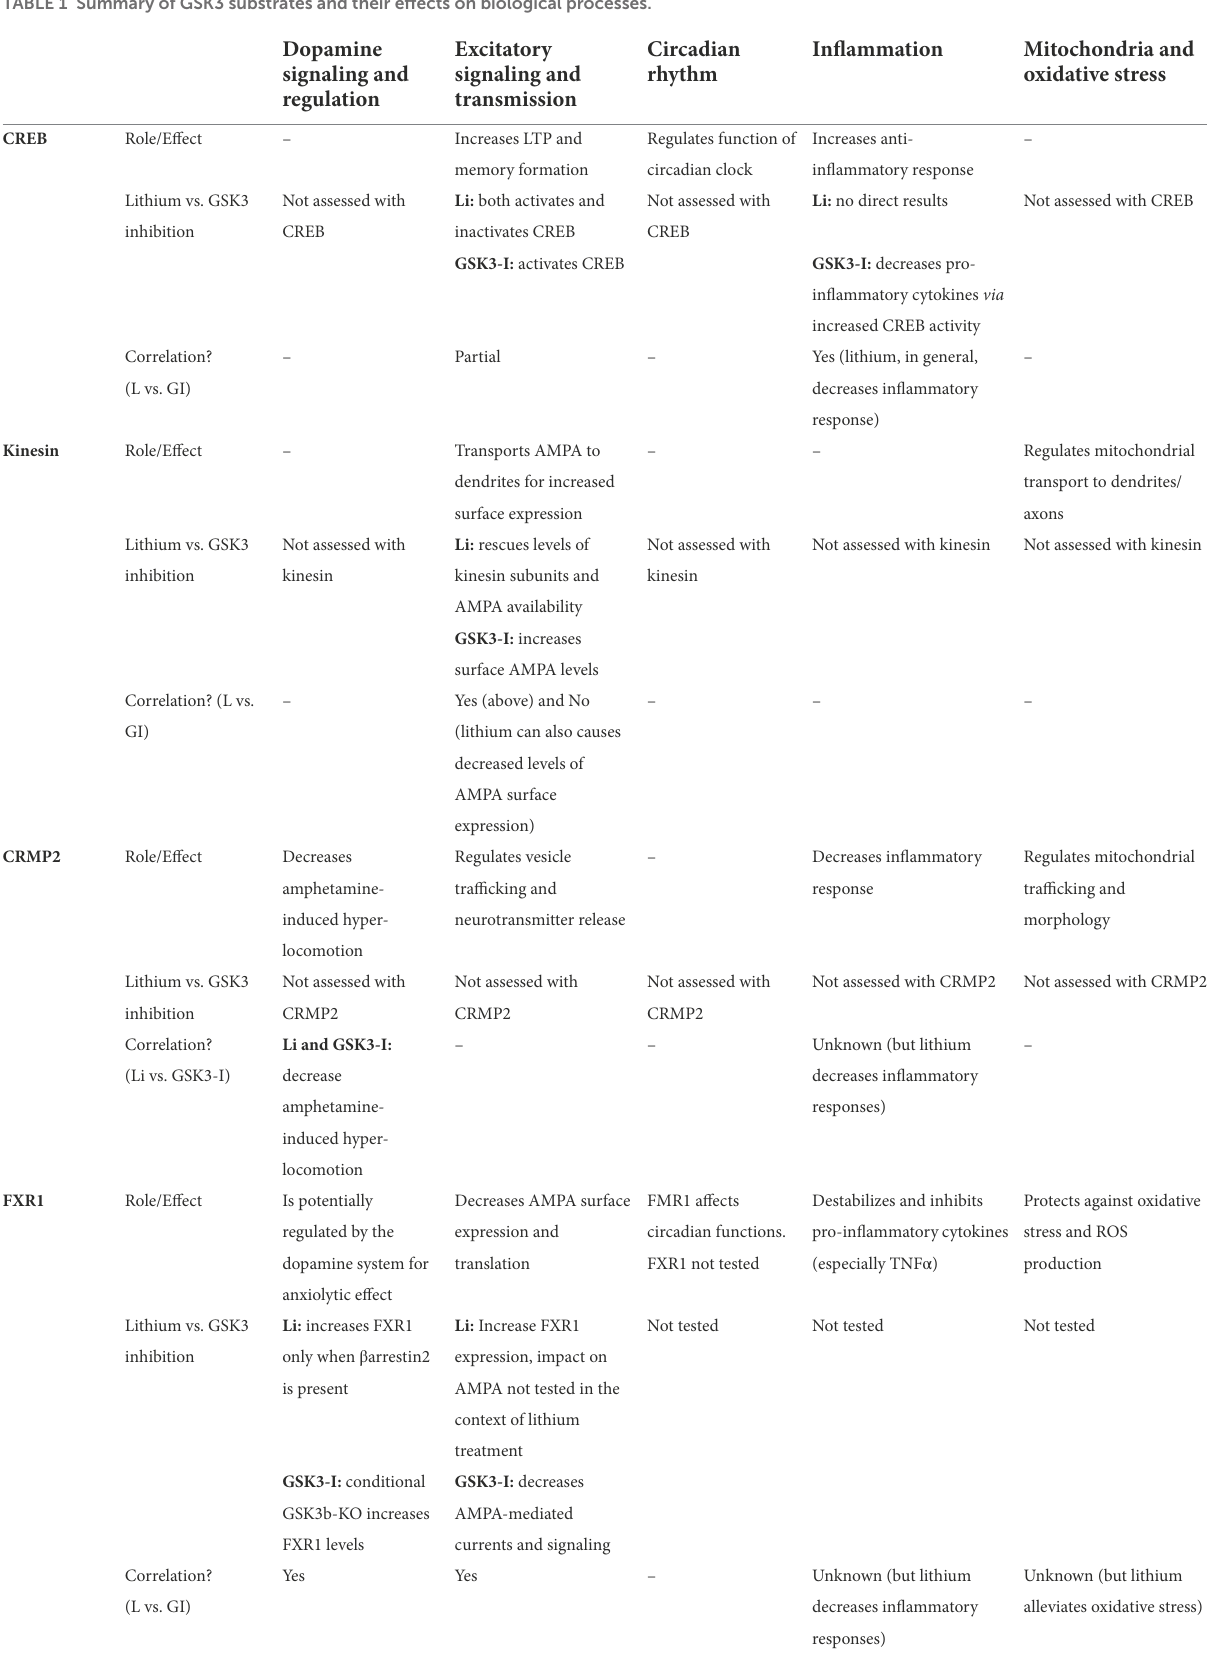
TABLE 1 Summary of GSK3 substrates and their effects on biological